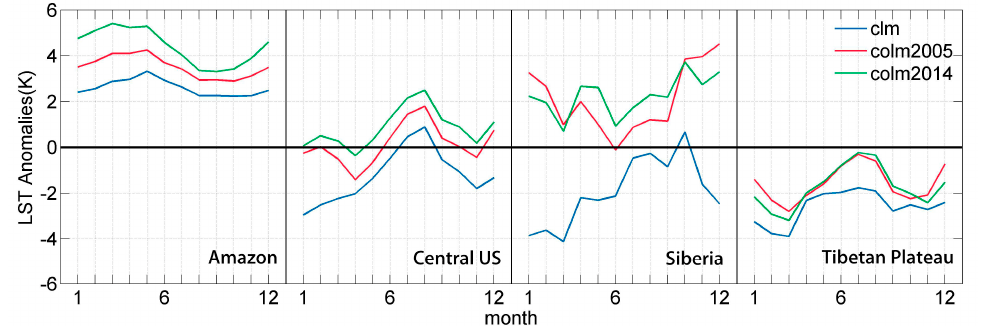
Figure 18. Anomalies of simulated LST from MODIS product (Simulation—MODIS) for four focus regions (Units: K).